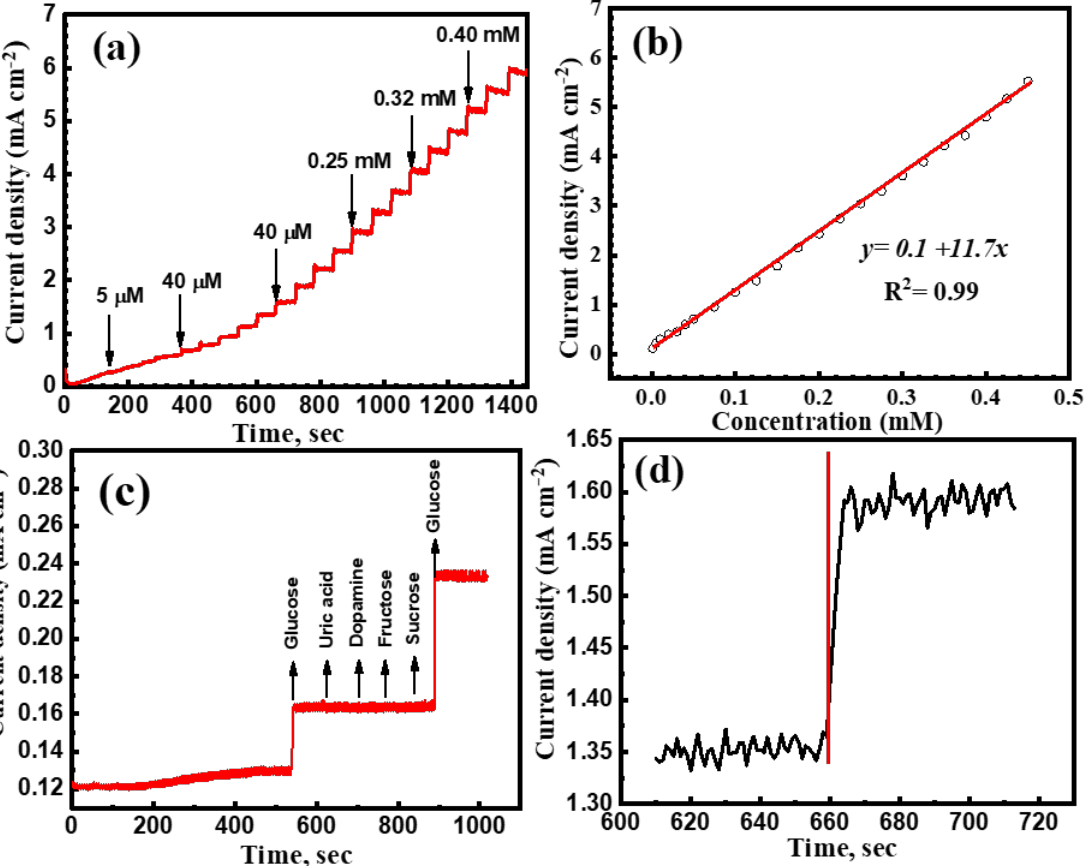
Figure 6. The chronoamperometric response of the mesoporous carbon coated with CuNi-MC sensor to ( a ) successive additions of higher glucose concentration, ( b ) calibration curve including the linear range, ( c ) after the addition of 40 µM glucose, uric acid, dopamine, fructose, and sucrose at pH 12 and – 0.6 V (Ag/AgCl) and ( d ) response time of the sensor to reach steady-state current density after the addition of 40 µM glucose.